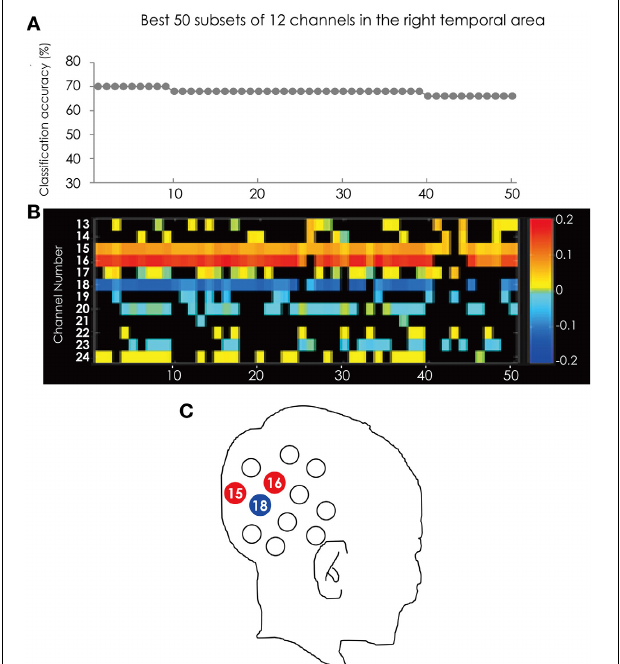
FIGURE 5 | (A) The classification accuracy corresponding with best 50 subsets consisted from the channels in the left hemisphere. (B) The channel numbers in the subsets represented in (A) . (C) The position of the channels referred to in the text.